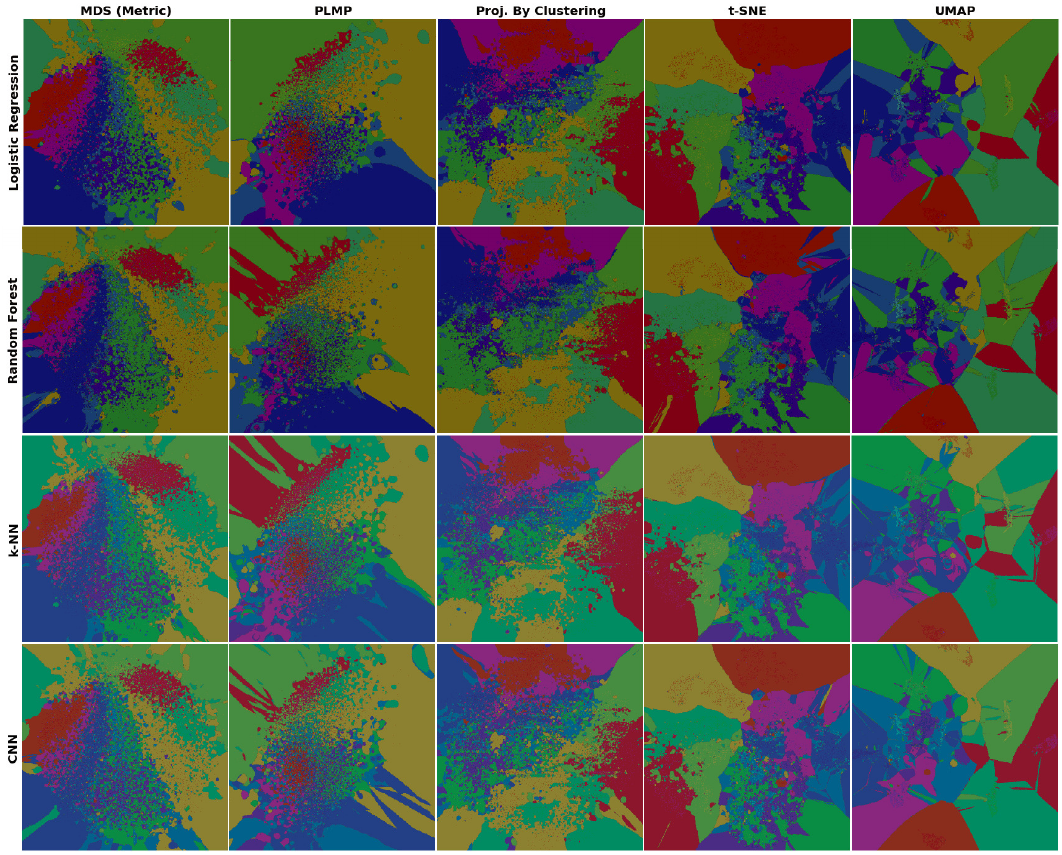
Figure 4. Dense maps for all classifiers, 10-class dataset, five best-performing